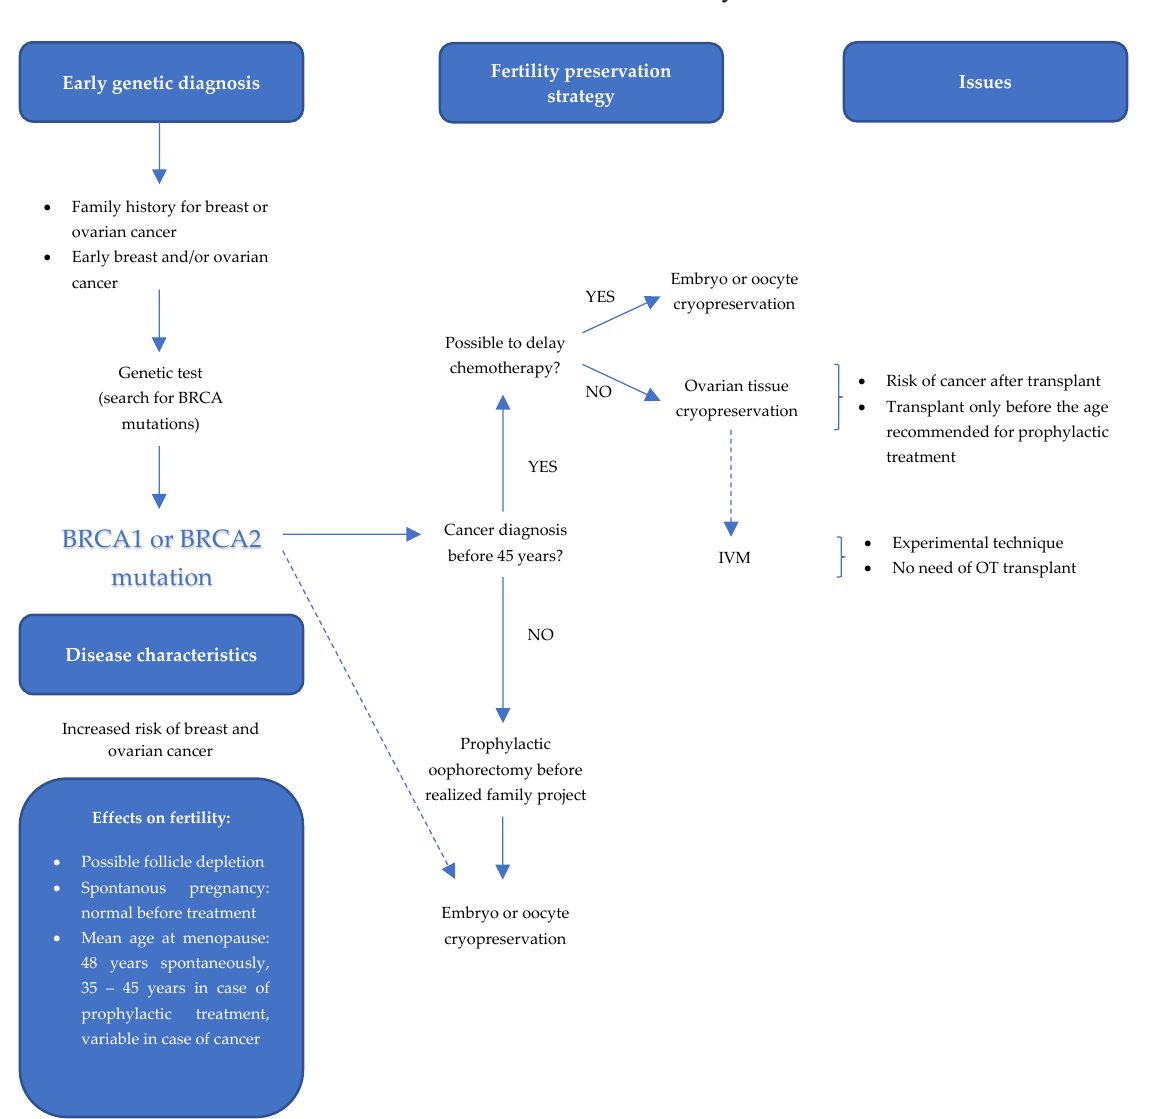
Early genetic diagnosis